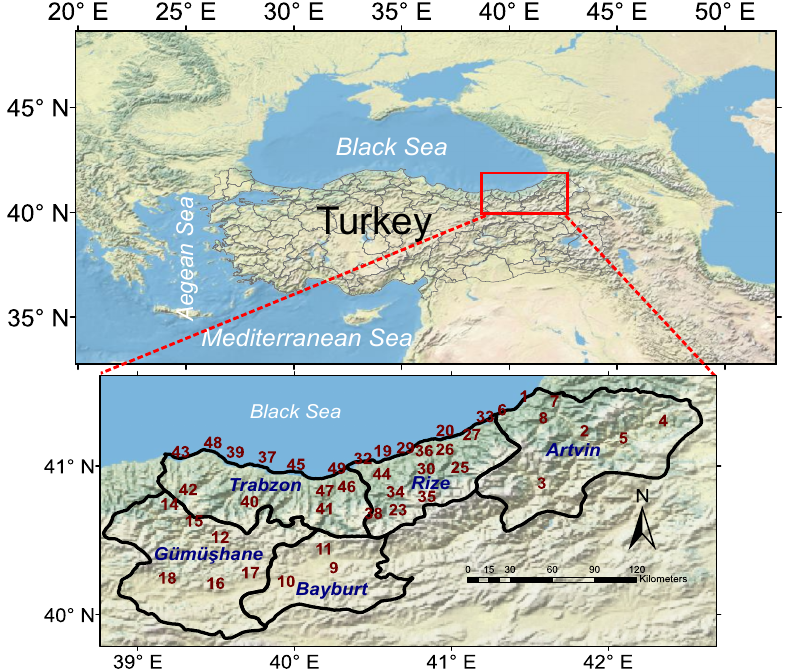
Figure 1. The eastern Black Sea region including city names and borders and 49 automated meteorological stations (descriptions of the station numbers are explained in Table 1). The outset shows location of the region in